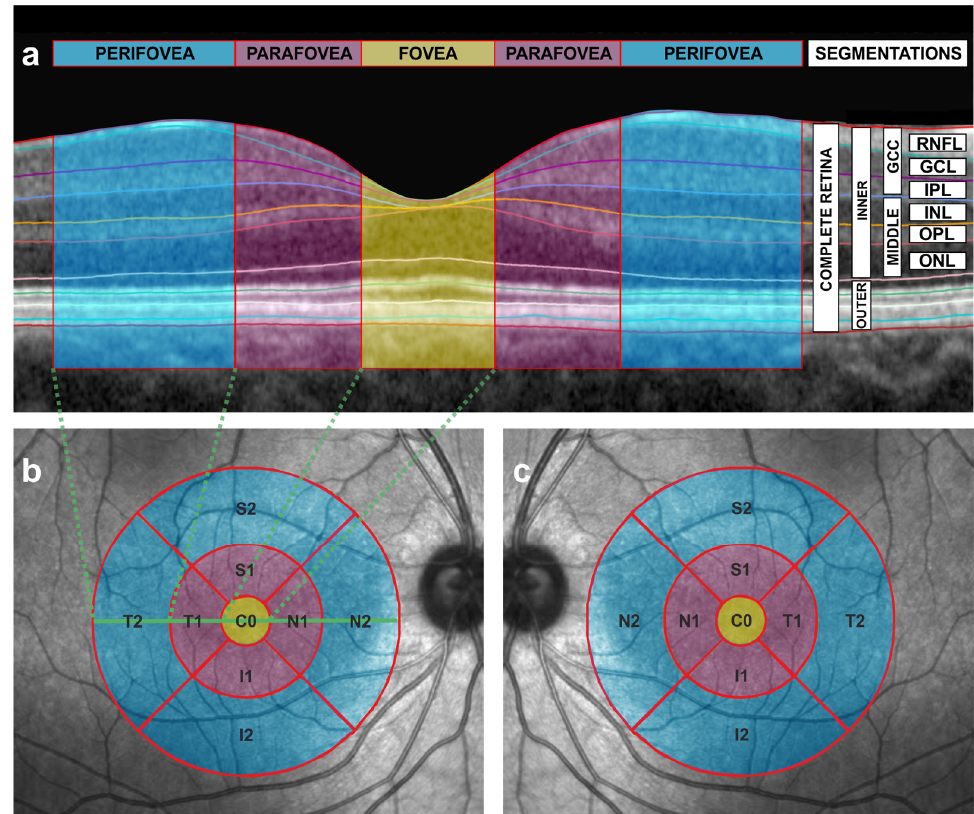
Figure 1. Cross-sectional and en face scans obtained by the means of optical coherence tomography (OCT). ( a ) Automatic segmentation of the different intraretinal layers in a cross-sectional OCT image of the macula from a right eye. The fovea is depicted in yellow, the parafoveal subfield in purple and the perifoveal subfield in blue. See Figure 1b,c for the corresponding en face representation of the fovea, parafovea and perifovea with the same color code as the one used in this figure. Dashed green lines indicate the limits of the temporal perifovea, the temporal parafovea and the fovea in relation to the en face image (see also Figure 1b). Segmentations are also shown. RNFL = retinal nerve fiber layer, GCL = ganglion cell layer (GCL), IPL= inner plexiform layer, INL = inner nu- clear layer, OPL = outer plexiform layer, ONL = outer nuclear layer, GCC = ganglion cell complex, MIDDLE = middle retinal layers, INNER = inner retina, OUTER = outer retina. ( b ) Early Treatment Diabetic Retinopathy Study (ETDRS) grid with concentric circles of 1, 3 and 6 mm diameters of the right eye, showing nine sectors of the macula in an en face OCT image. The OCT device automatically estimates the mean thickness in microns for each sector and for each segmentation (see also Figure 1a). T = temporal, N = nasal, S = superior, I = inferior, C0 = fovea. Number 1 and number 2 refer to the